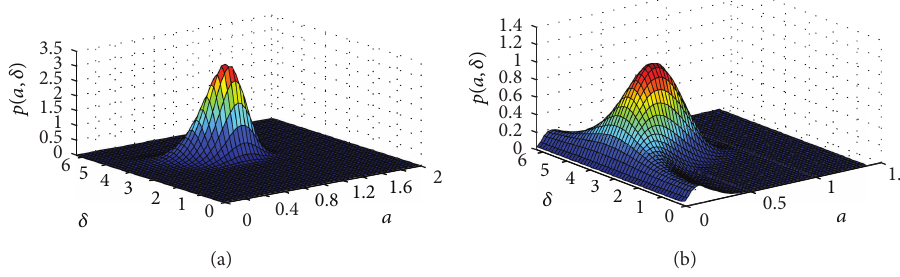
Figure 8: Joint stationary probability density 𝑝(𝑎, Δ) . (a): No fast excitation; (b) 𝐸 22 ⋅ 𝑟 𝑓 = 0.8